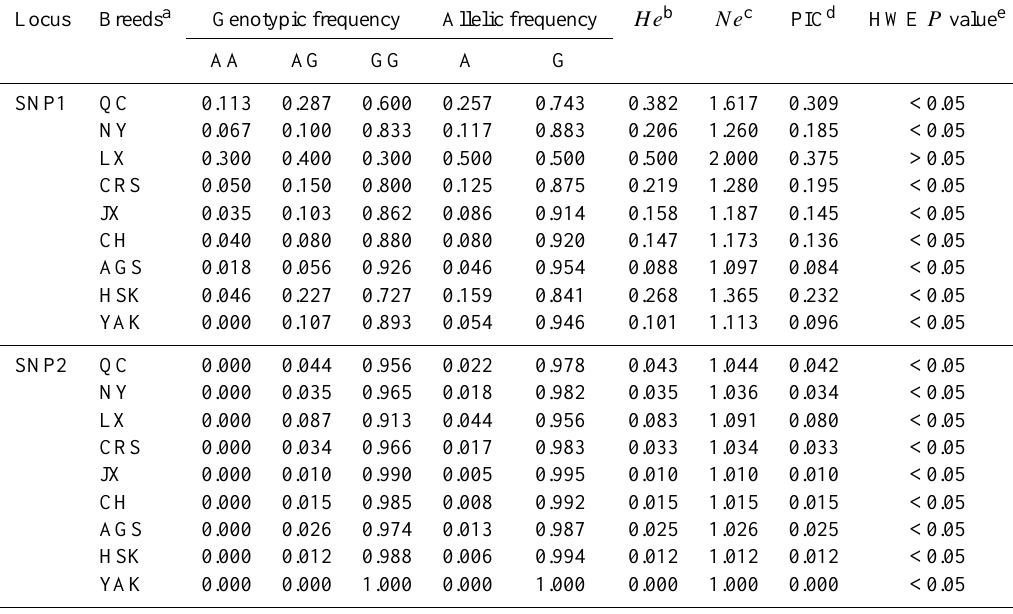
Table 3. Genetic diversity at Alu I and Hin f I locus of the bovine NRIP1 gene.